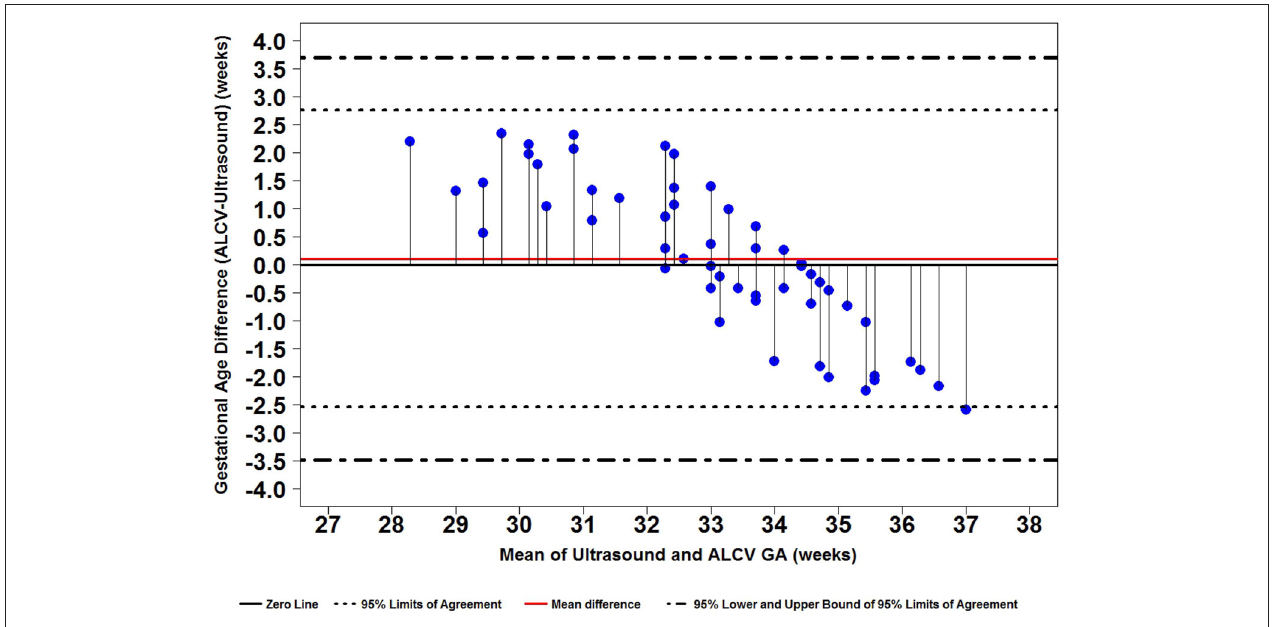
FIGURE 3 | Bland-Altman plot of difference in gestational age against the mean of the two